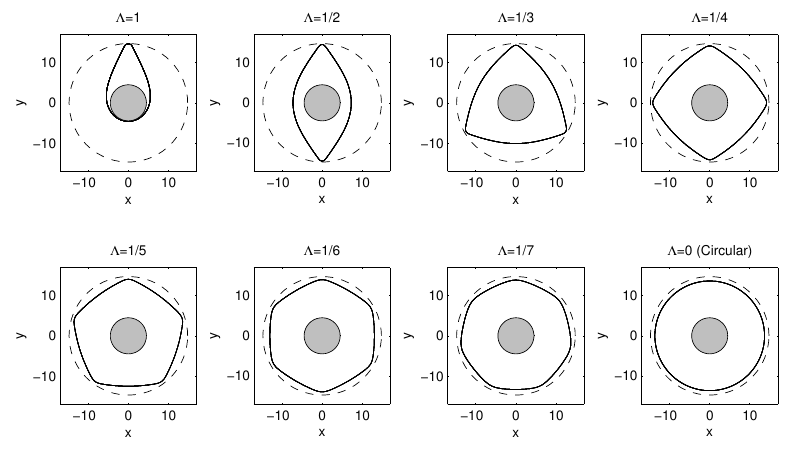
Figure 2. Periodic orbits with angular momentum L found from Λ = 1, 1/2, 1/3, 1/4, 1/5, 1/6, 1/7 and the stable circular orbit. The CO is the shaded disc, and the unstable circular orbit is marked with a dashed